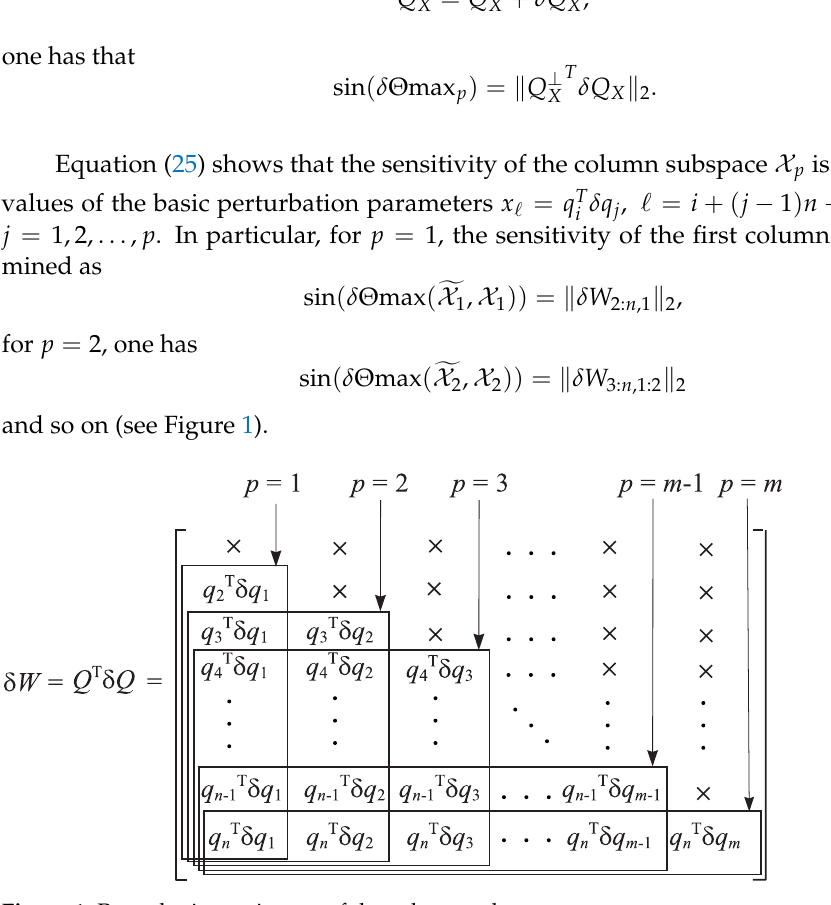
Figure 1. Perturbation estimates of the column